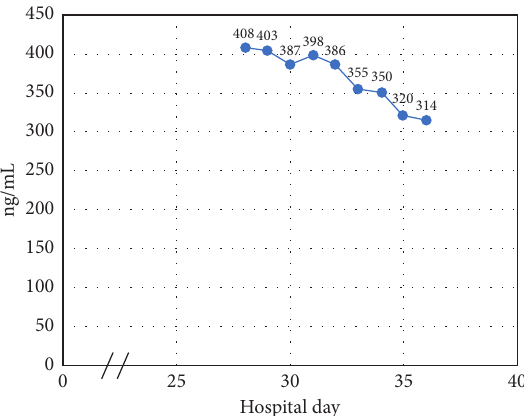
Figure 2: Serum 25-hydroxyvitamin D levels by dilution during